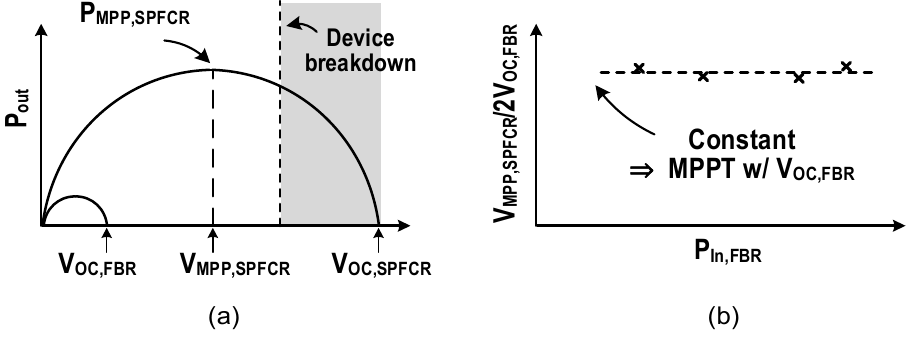
Figure 16. Illustrative diagram showing ( a ) relationship among V OC , FBR , V MPP , SPFCR , and V OC , SPFCR , ( b ) empirical constant ratio between V MPP , SPFCR and V OC , FBR over the FBR equivalent input power (Reprinted/adapted with permission from Ref. [37]. 2022, Zhiyuan Chen).